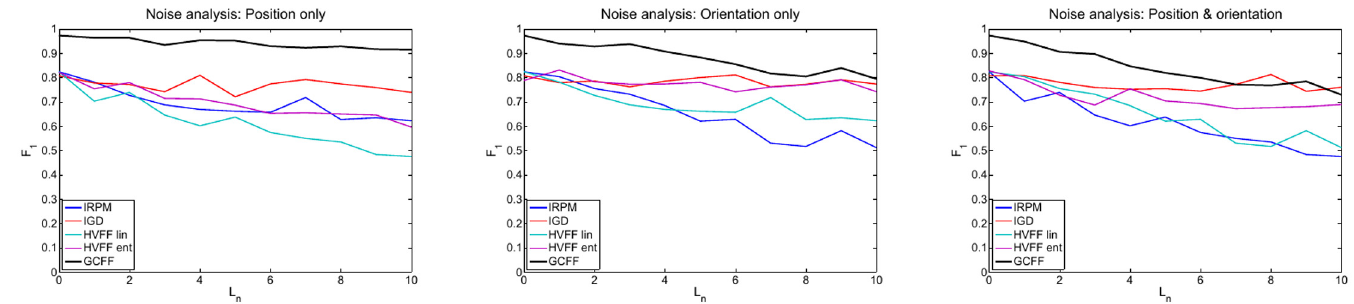
Fig 8. Noise analysis. F 1 score VS . Noise Level on position (left), orientation (centre) and combined (right). (Best viewed in colour)